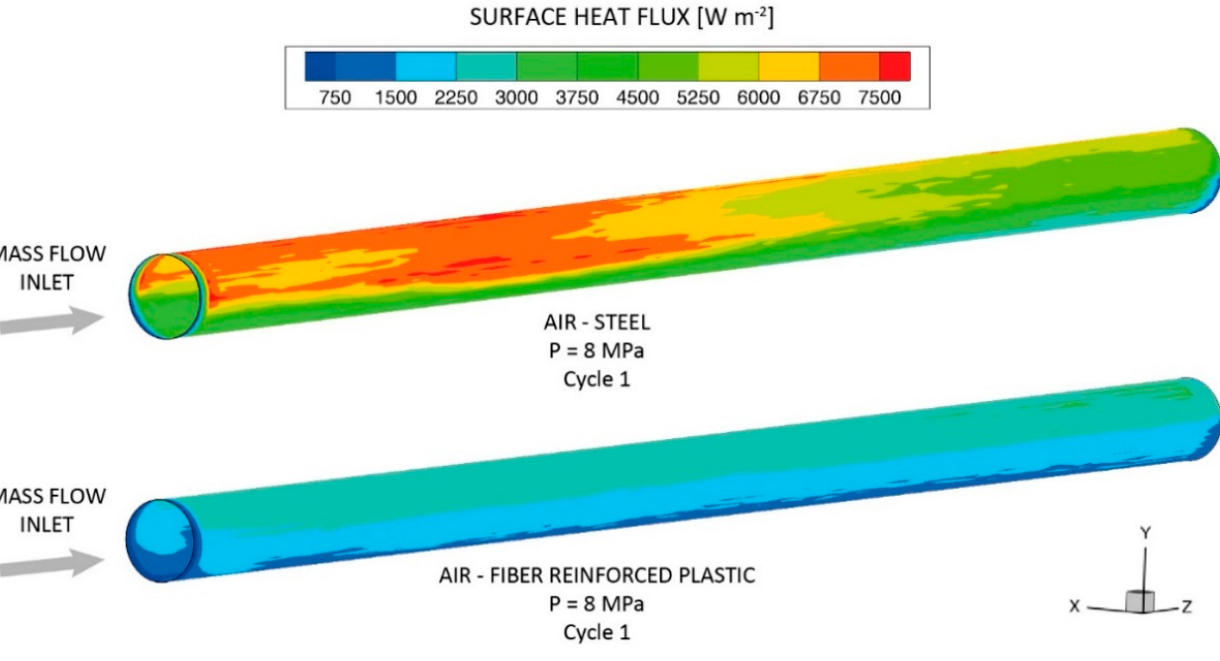
Figure 13. Numerical model results. Distribution of surface heat flux for FRP and steel in the first cycle at a pressure of 8 MPa in the contact surface air-sealing layer.